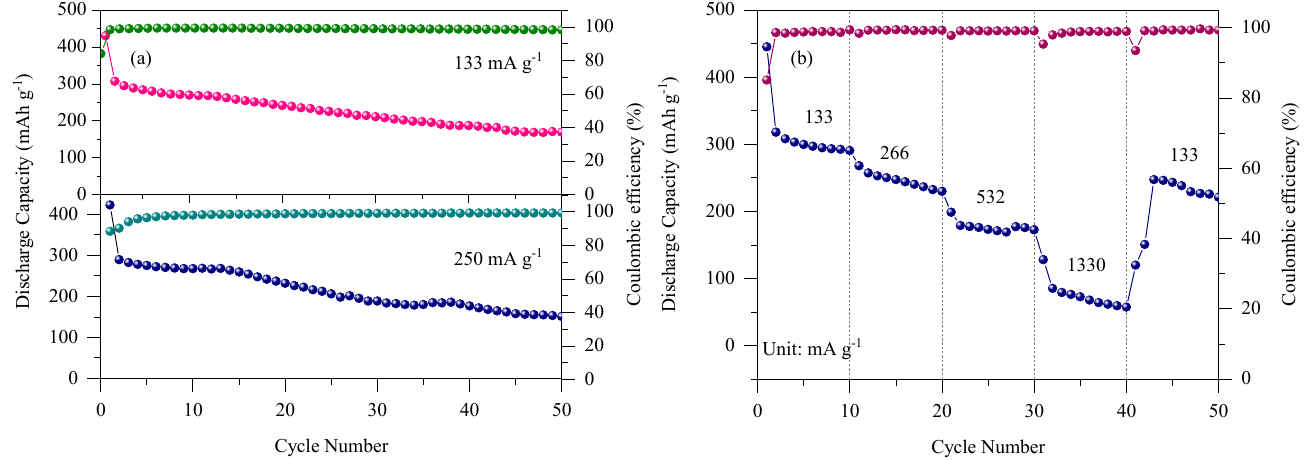
Figure 5. ( a ) Cycling performance at the constant current densities of 133 and 250 mA g − 1 until 50 cycles and ( b ) the capacity retention at various current densities from 133 to 1330 mA g − 1 of the oval-shaped V 2 O 5 nanoparticles electrode.